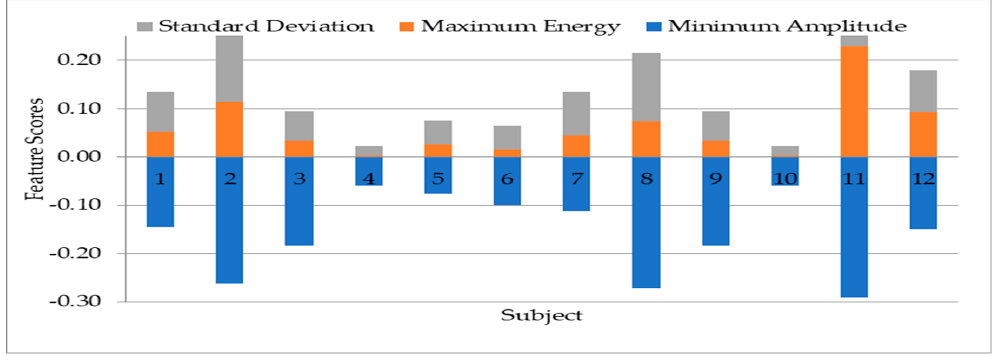
Figure 9. Variation of minimum amplitude, maximum energy, and standard deviation on twelve subjects.